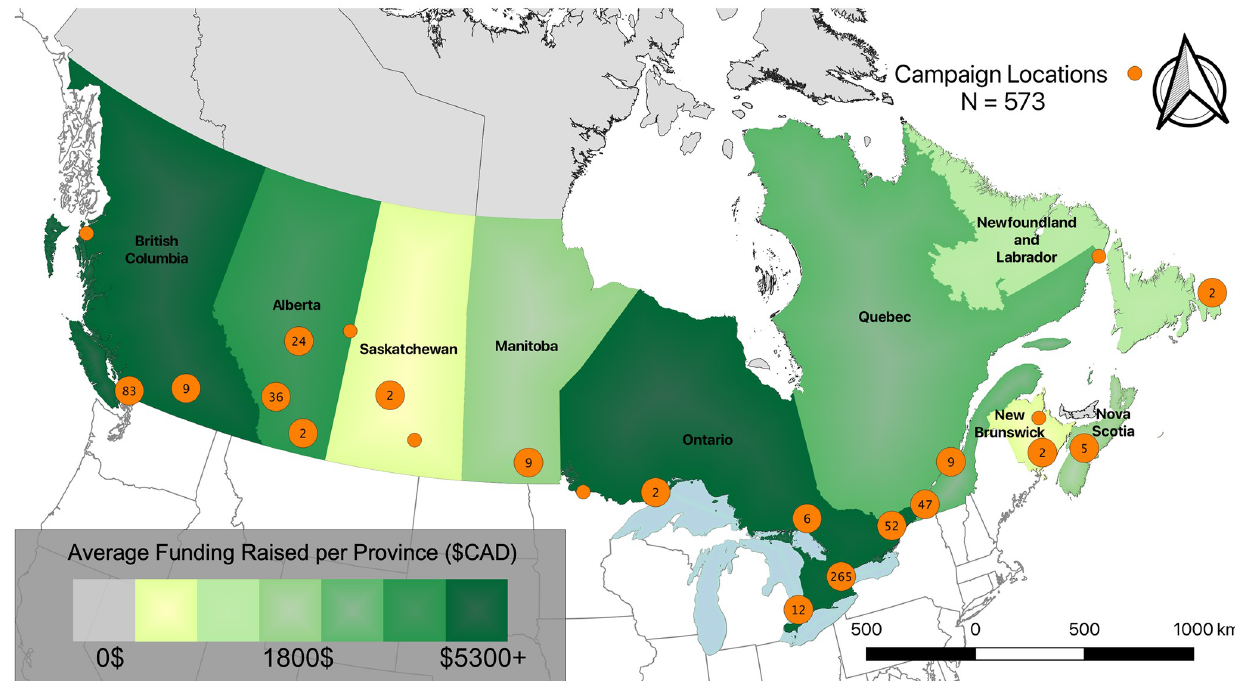
Fig 7. Spatial distribution of campaigns in Canada and average campaign funding per province. Most campaigns in Canada were found to be surrounding the country’s major metropolitan areas, like Toronto, Vancouver, Montreal, and Ottawa. Ontario showed the highest average donation, Saskatchewan the